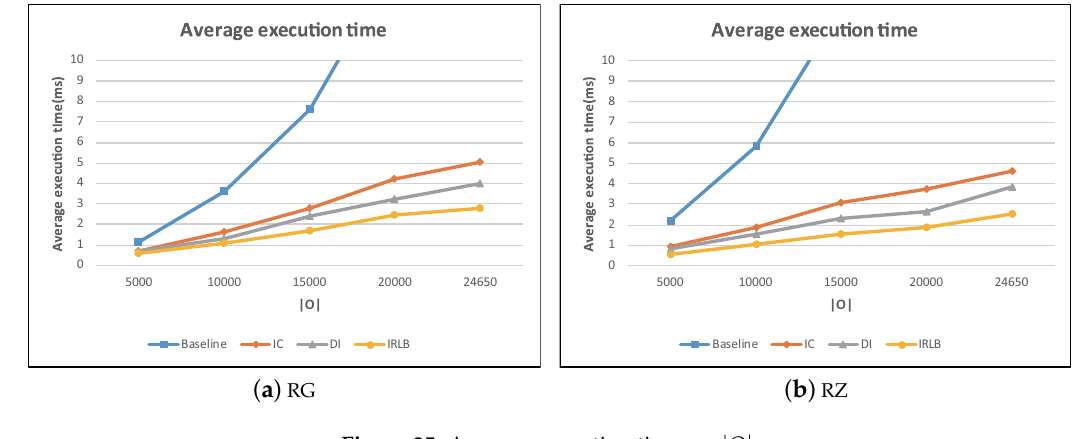
Figure 25. Average execution time vs. | O | .